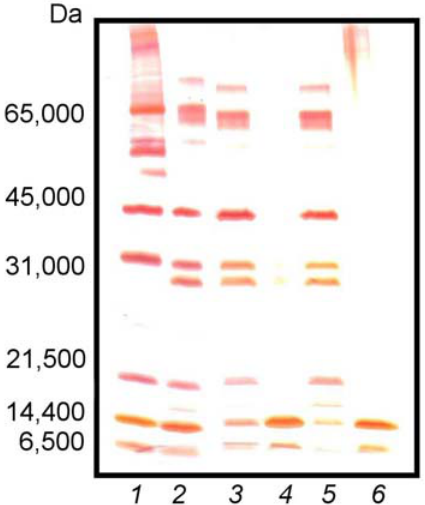
Figure 5. SDS-PAGE analysis of dye-loaded core-shell particles and dye-loaded magnetic hydrogel particles incubated with MW markers: ( 1 ) MW ladder; ( 2 ) model protein solution; ( 3 ) supernatant from dye-loaded core-shell particles; ( 4 ) bound by dye-loaded core-shell particles; ( 5 ) supernatant from dye-loaded magnetic hydrogel particles; ( 6 ) bound by dye-loaded magnetic hydrogel